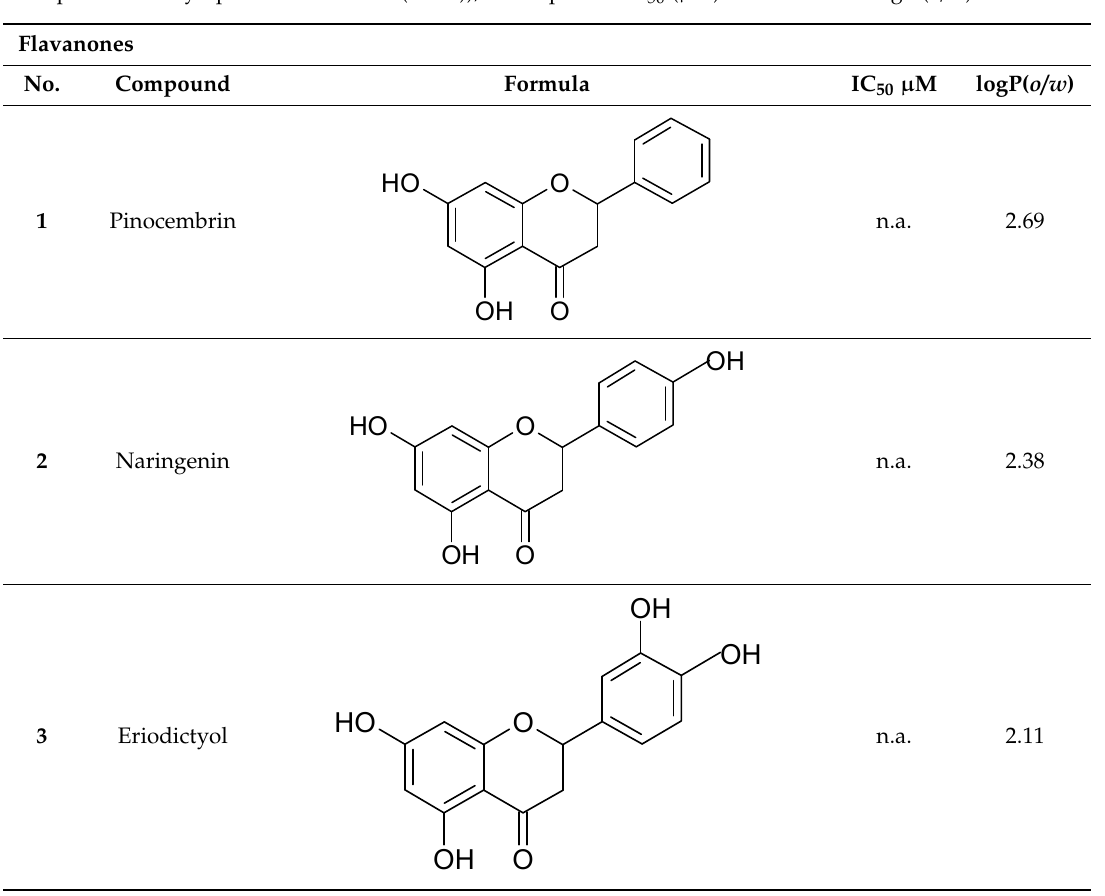
Table 1. Compounds tested in the circular chemorepellent-induced defects (CCID) assay (MCF-7 spheroids on lymph endothelial cell (LECs)), the respective IC 50 ( μ M) and calculated logP (o/w)